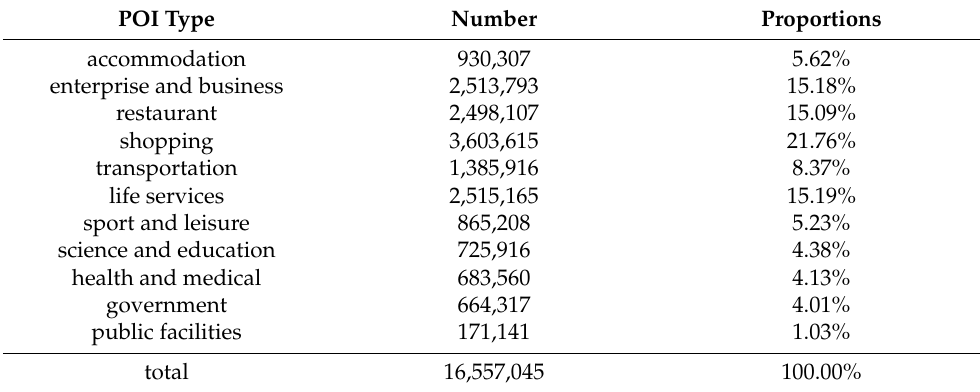
Table 1. Quantitative proportion of each first-level POI type in the dataset.